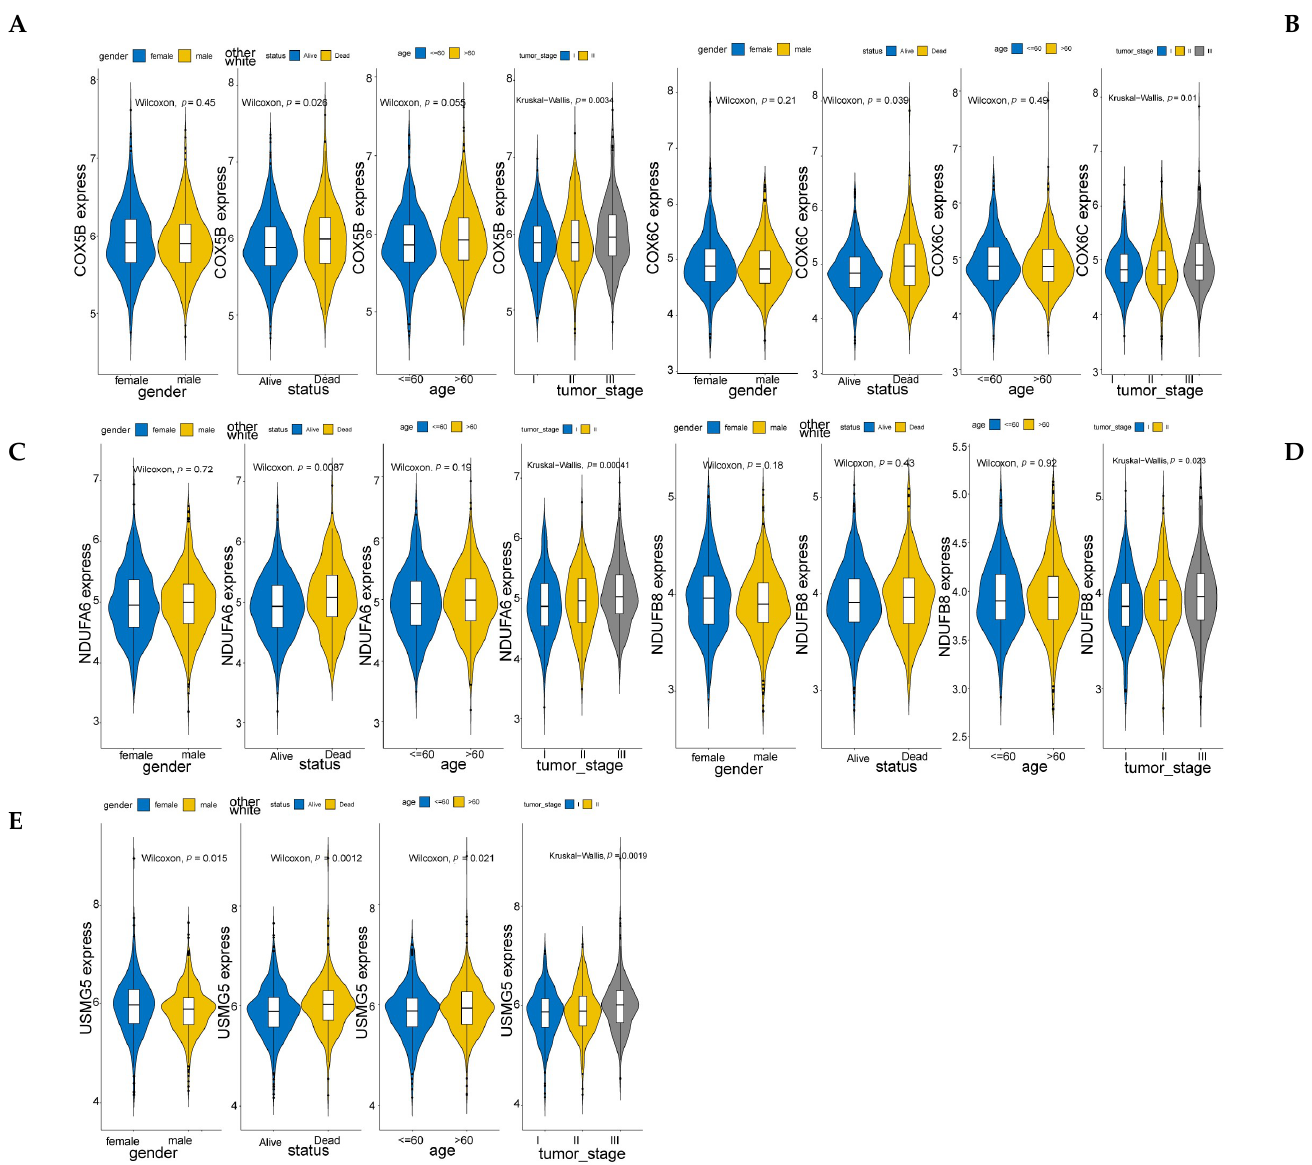
Figure 7. Identification of the correlation between expression of prognostic hub genes and clinical characters. ( A – E ) A close correlation was found between NDUFB8, NDUFA6, COX5B, COX6C, and USMG5 expression in MM, the stage of the tumor and the prognosis.